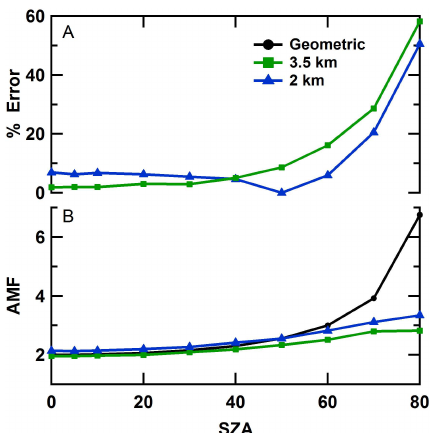
Fig. 5. (A) Relative error of geometric air mass factor (geoAMF) compared to AMF for nadir geometry calculated using RTM, McArtim for flight altitude of 3.5km (green) and 2km (blue)a.g.l., for most likely atmospheric conditions in South Coast Air Basin (SCAB). (B) AMF calculated using McArtim (green and blue) and geoAMF (black). Most likely atmospheric state in SCAB: surface albedo=0.10, single scattering albedo=0.94, g parameter=0.68, aerosol optical depth=0.4, boundary layer height=1km and NO 2 mixing